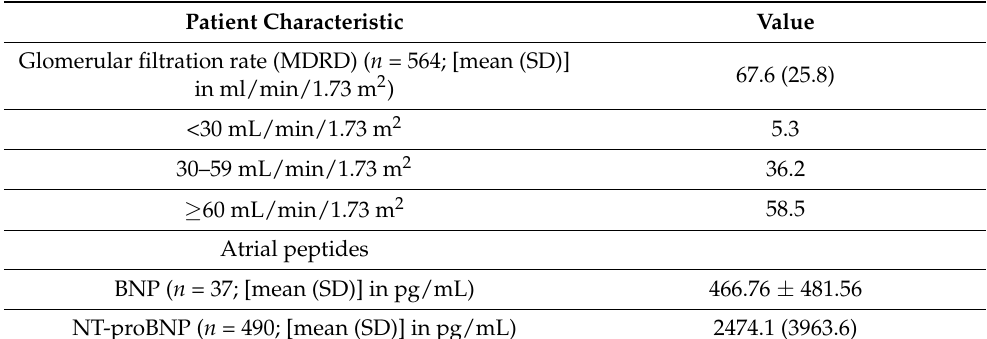
Table 1. Cont. Patient Characteristic Glomerular filtration rate (MDRD) ( n = 564; [mean (SD)]